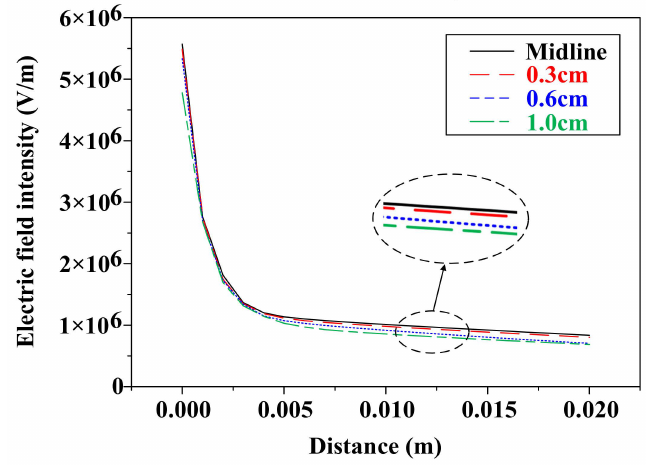
Figure 10. Electrical field intensity distribution curves of insulating dielectric needle plate electrodes at different distances from the central axis.